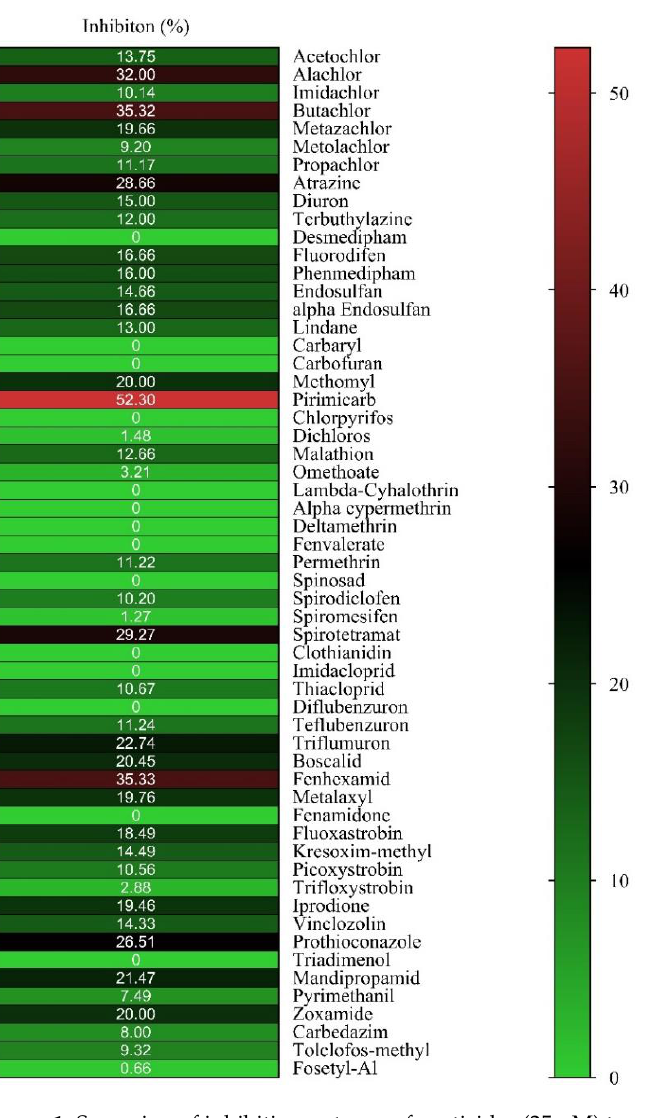
Figure 1. Screening of inhibition potency of pesticides (25 µ M) towards hGSTM1-1. The isoenzyme was assayed in all measurements using CDNB-GSH assay system. The colors represent the mean values of three inhibition assays (%) for each pesticide against the tested enzyme with a variation less than 5% in all cases.